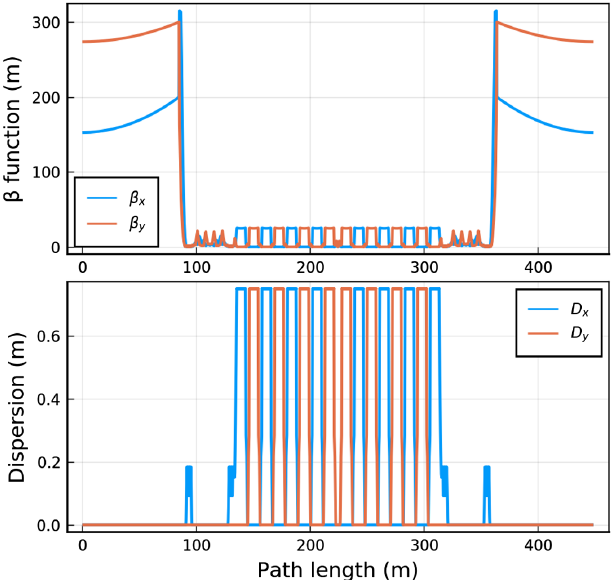
FIG. 3. Optics of the ring cooler.